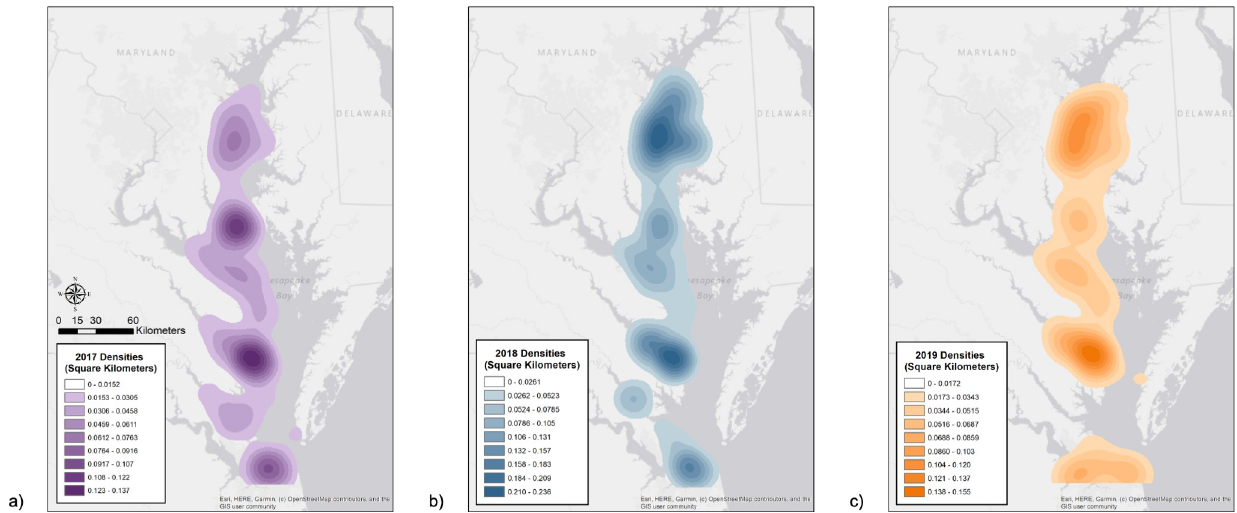
Fig 5. Spatial density of dolphin sightings. Maps showing the densities (sightings per kilometers 2 ) of confirmed bottlenose dolphin sighting reports from Chesapeake DolphinWatch (a– 2017, b– 2018, c– 2019). Darker colors indicate higher densities. Map attribution: ESRI, HERE, Garmin, OpenStreet Map.